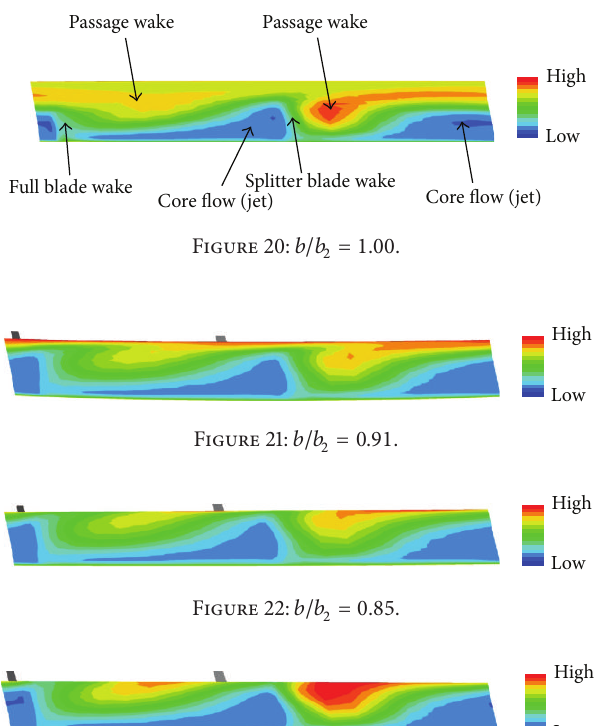
Figure 23: 𝑏/𝑏 2 = 0.81 .